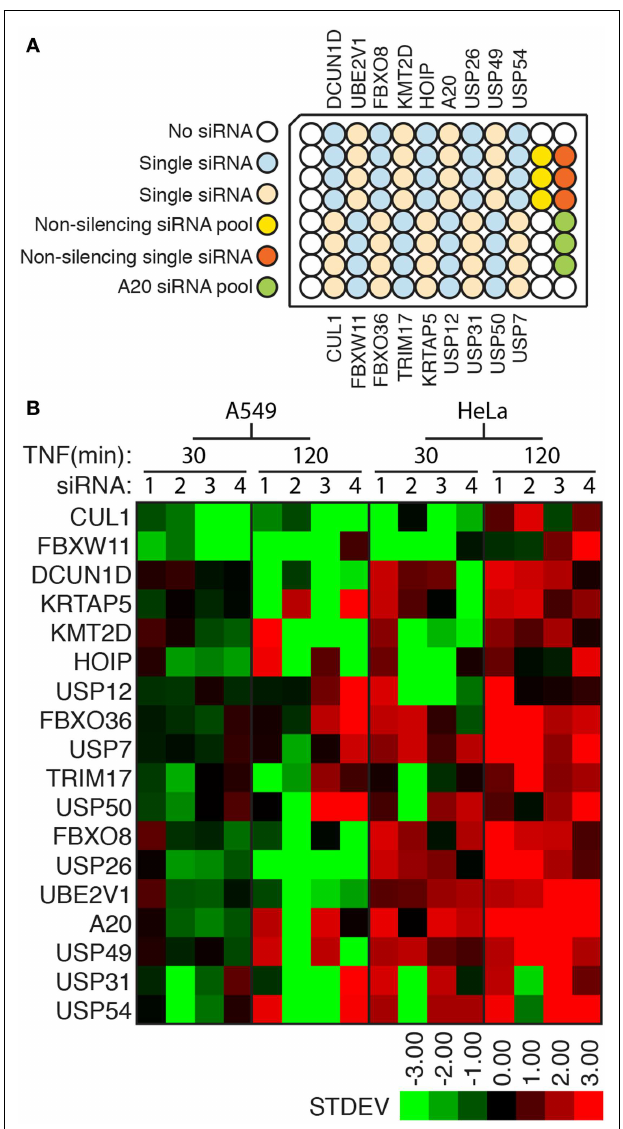
FIGURE 6 | (A) Arrangement of experimental and control siRNA duplexes in a secondary assay for ubiquitin modifiers that control the nuclear translocation of NF- κ B. (B) Graphical overview of the nuclear accumulation of NF- κ B as a number of standard deviations from control non-silencing siRNA duplexes in HeLa or A549 cells treated with the respective siRNA duplexes andTNF for the indicated